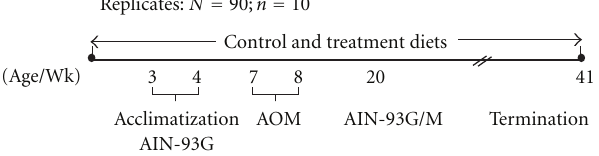
Figure 1: Experimental design of feeding control and treatment diets in F344 male rats. Scale is not proportional. (1) Control diet is based on AIN-93G/M (American Institute of Nutrition— 93Growth/Maintenance) [22, 23]. (2) Treatment diets: 5%, 10% Prebiotics and Soybean meal fed singly and in combinations. (a) Rats: N = 90; n = 10 (Replicates = 5), (b) T ± 21 ◦ C; Relative humidity = 50%, (c) day and night = 12 hr. each, (d) Azoxymethane (AOM/colon specific carcinogen) dose = 16mg/kg of body weight. The protocol involving animals was approved by the Institutional Animal Care and Use Committee of Alabama A&M